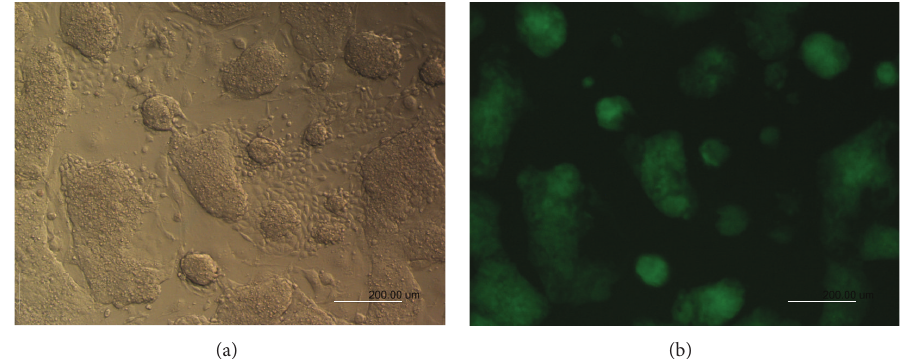
Figure 1: ESC and iPSC cultures without feeder cells. ES cells were cultured on day 3 after thawing: bright field (a) and GFP fluorescence (b).